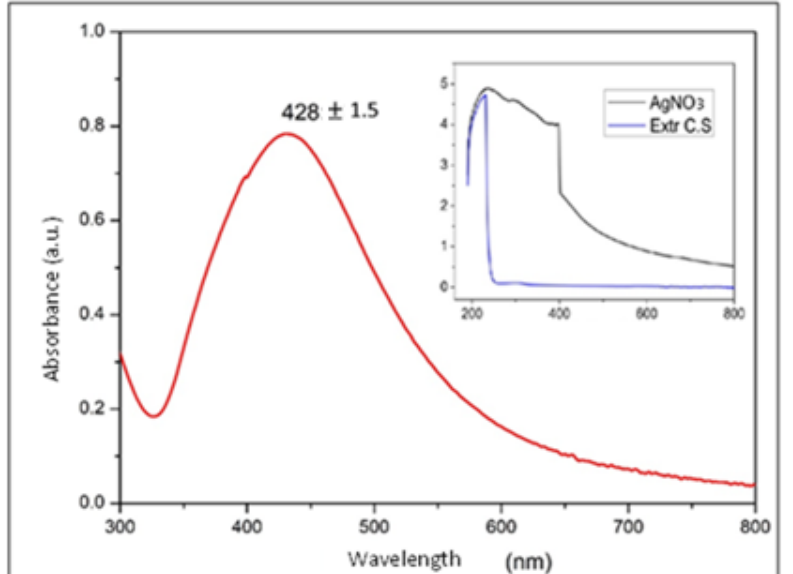
Figure 6. UV – Vis spectra at different scales of silver nanoparticles and the Coriandrum sativum extract with AgNO 3 .